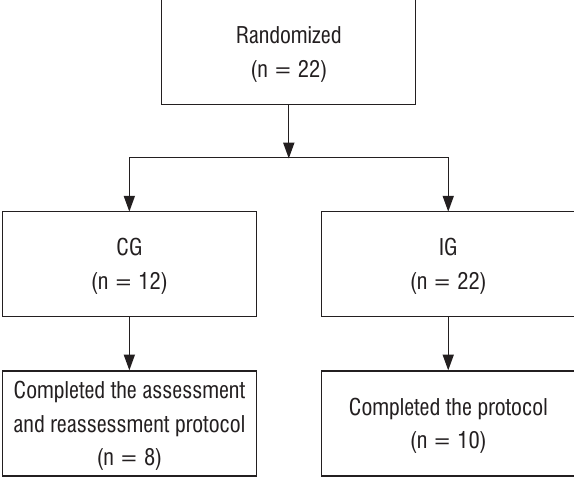
Figure 1 - Flowchart of the study patients. Note: CG = control group, IG = intervention